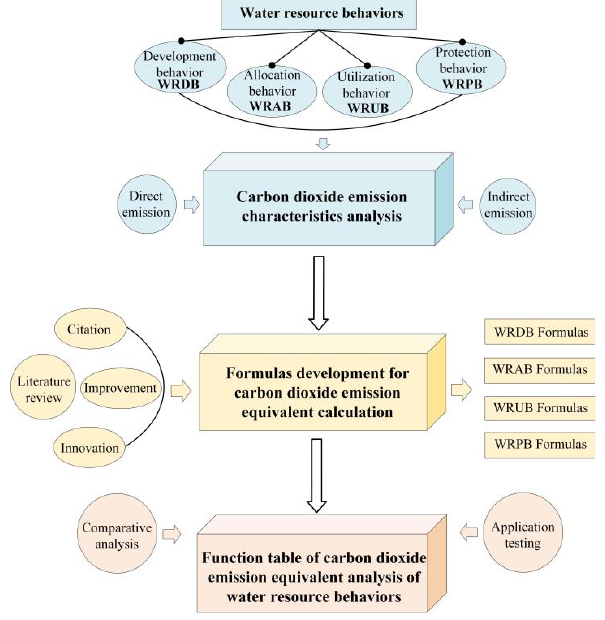
Figure 1. The general idea of the CEEA method.